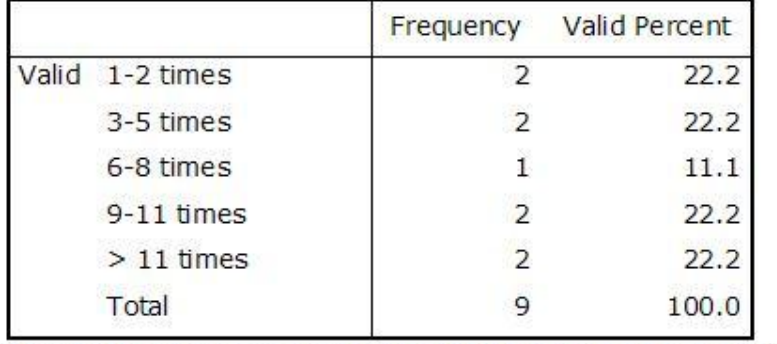
Fouche ~ A Multi-Island Situation Without the Ocean: Tutors’ perceptions about working in isolation from